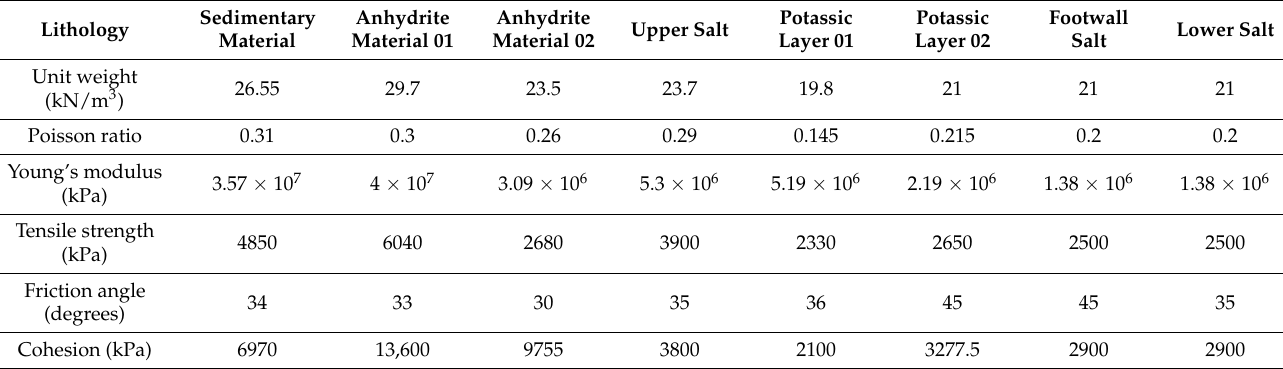
Figure 4. Example of an RS2 model with the geological and drifts characteristics. Table 1. Values of geomechanical properties for each lithology.